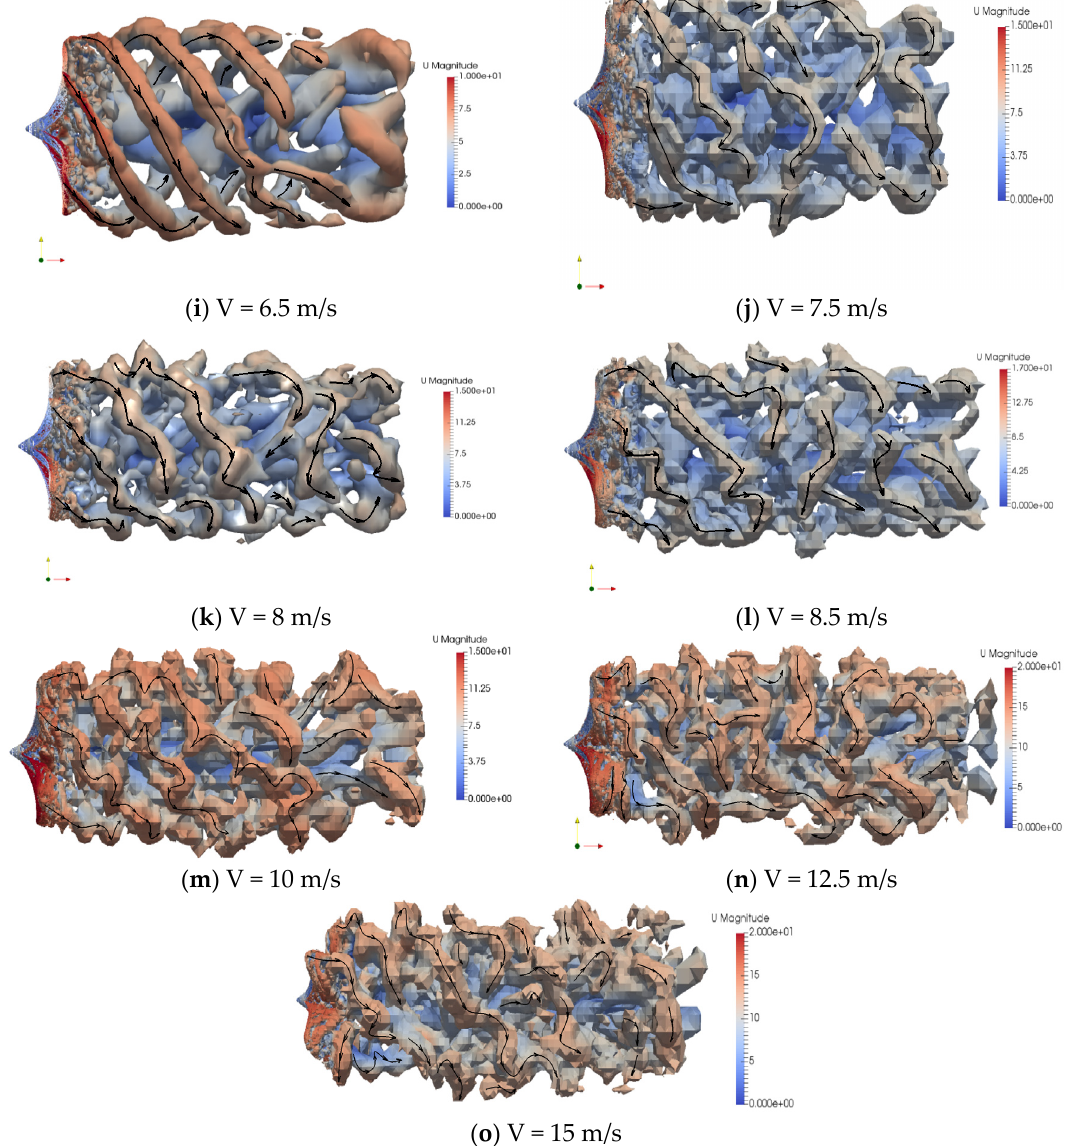
Figure 21. Vortex structure for different upstream velocities. Rotor UN-V1.